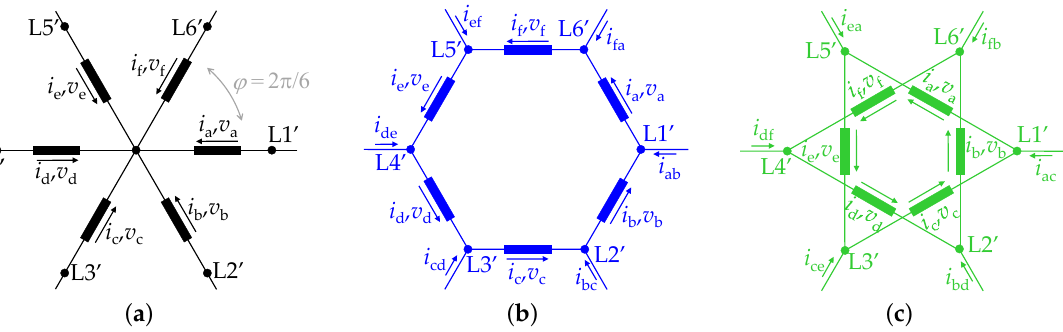
Figure 7. Stator phase connections in a six-phase machine with symmetrical WSA [408]. ( a ) λ = 0 (star). ( b ) λ = 1 (hexagon). ( c ) λ = 2 (double